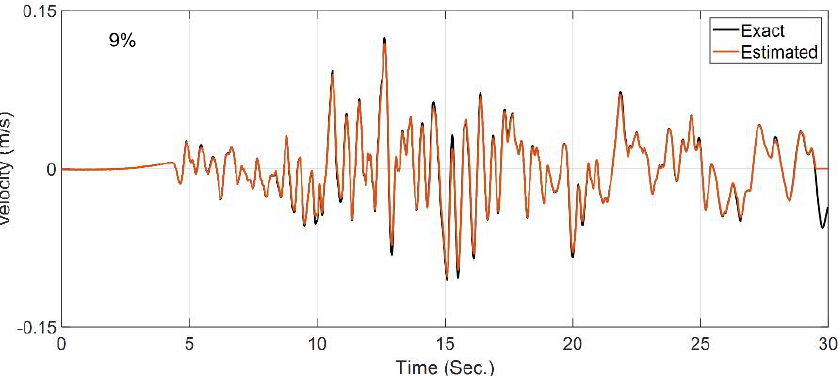
Figure 8. Comparison between the true incident motion and the estimated incident motion in Case Study 2.